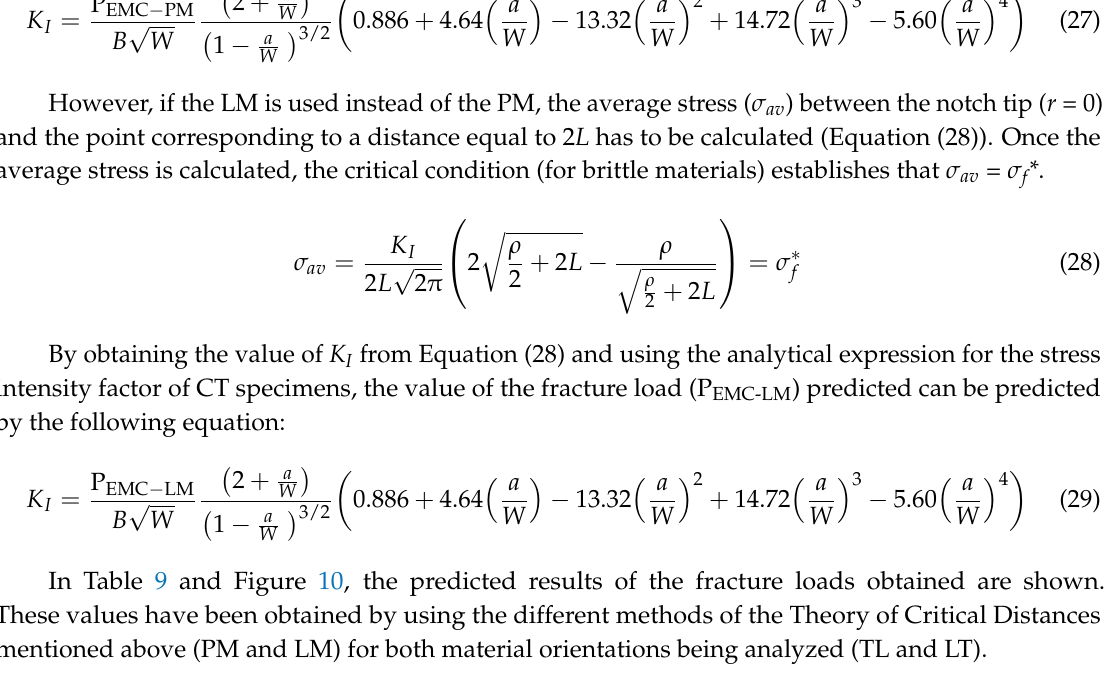
Table 9. Equivalent Material Concept-Theory of Critical Distances (EMC-TCD) fracture loads for TL and LT specimens using the PM and the